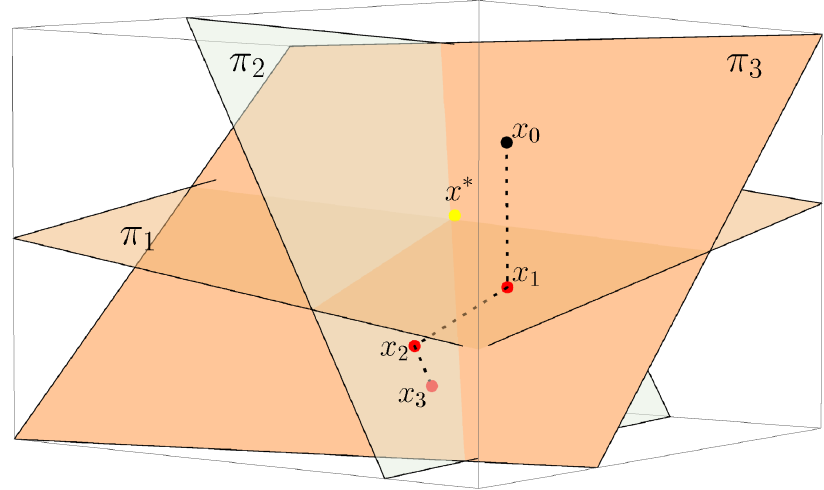
Figure 3. Geometric interpretation of the Kaczmarz’s